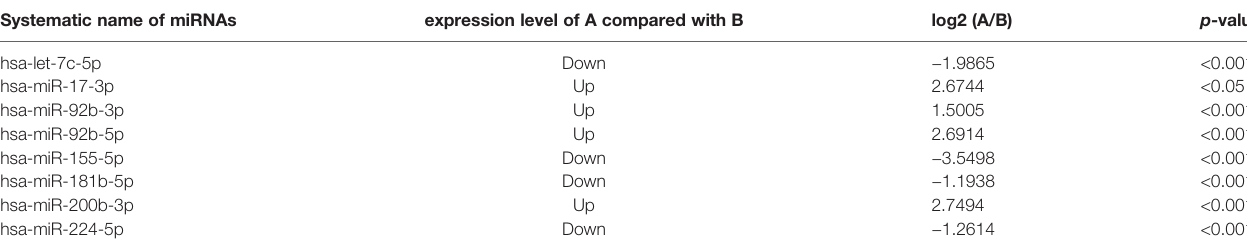
TABLE 2 | Differential expression of miRNAs between A549 and BEAS-2B cells